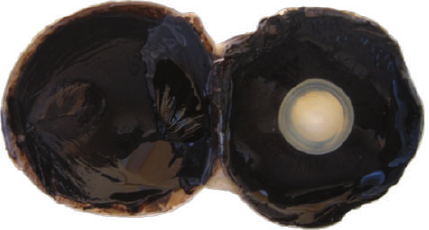
Figure 1: The appearance of pecten oculi of the ostrich.